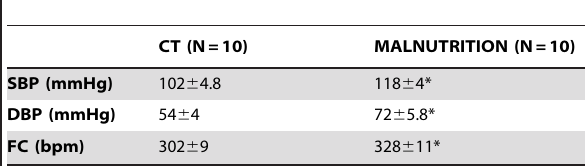
Table 3. Systolic (SBP, mmHg) and diastolic (DBP, mmHg) blood pressure and heart rate (HR, bpm) determination in the control (CT) and post-weaning protein malnutrition (Malnutrition) adult rats.